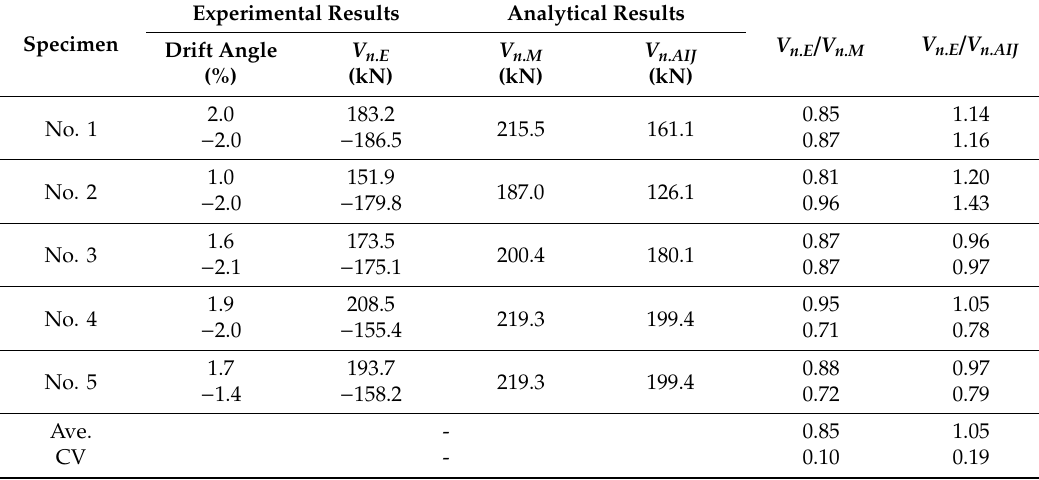
Table 5. Comparison between experimental and analytical results. Experimental Specimen